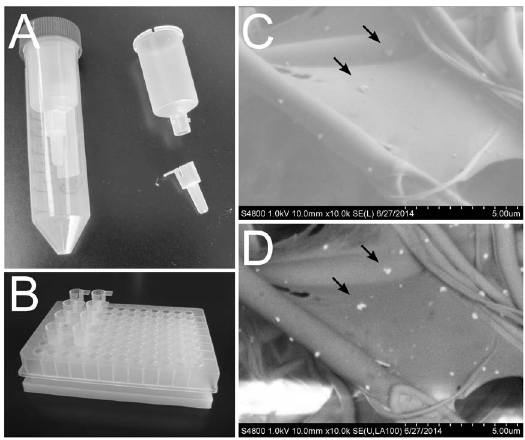
Figure 1. Exosomes and Microvesicles (EMV) Capture Device. A. A picture of assembled EMV capture device (left) and its components: syringe tube (top right) and filter tip (bottom right). B. A picture of filter tips aligned in a 96-well microplate format on top of oligo(dT)- immobilized microplate. C, D. Scanning electron microscope (SEM) analysis of urinary particles captured on the filter fiber. The filter was labeled with anti-CD63 antibody and colloidal gold with silver enhancement. The filter was analyzed by the lower detector mode